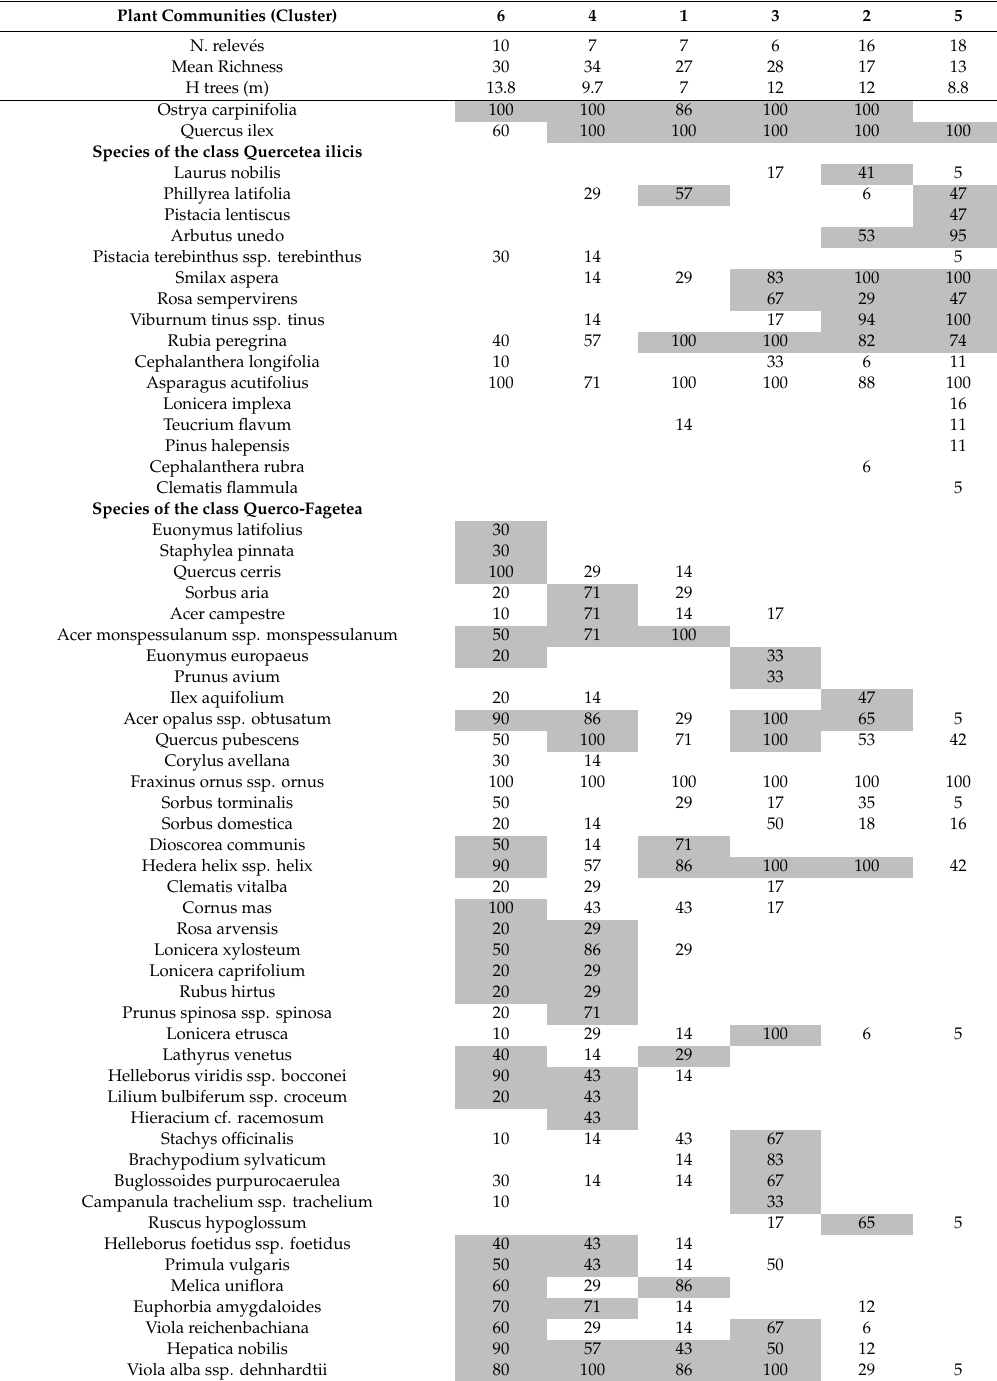
Table A1. Summary frequency table (percentage) of species composition of six forest plant communities (clusters) identified by noise fuzzy clustering analysis of 64 field phytosociological relev é s of forests of Mount Conero and Mount Valmontagnana (Marche, central Italy). Species with at least 3 occurrences were reported. Species indicators are in gray ( phi > 0.4, p -value <